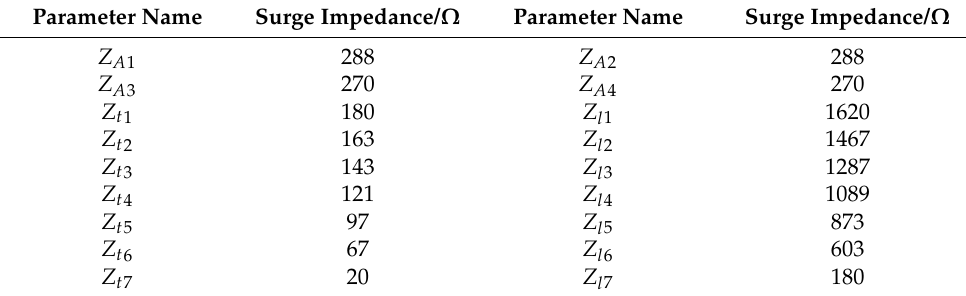
Table 4. Parameters for six segments of the nominal height.